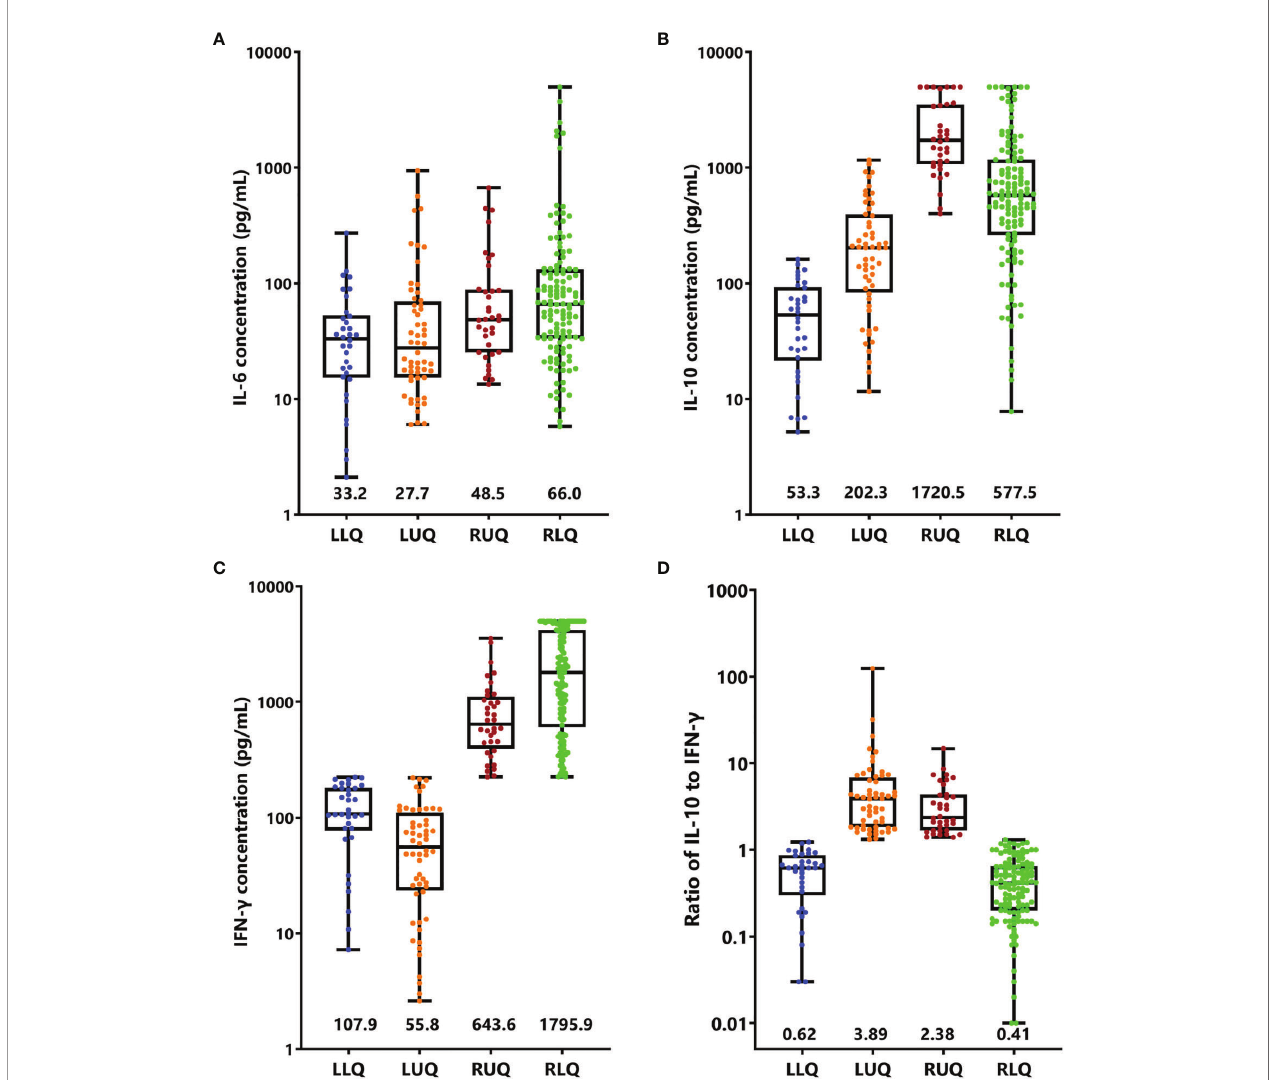
FIGURE 4 | Cytokine levels and ratios in four quadrants. Box-and-whisker plots of IL-6 (A) , IL-10 (B) , IFN- g (C) , and ratio of IL-10 to IFN- g (D) were shown. Median levels (lines), 25th to 75th percentiles (box), and minimum to maximum values (whiskers) are shown. The numbers in the plots are the median concentration of each cytokine or ratio. LLR, left lower quadrant; LUR, left upper quadrant; RUQ, right upper quadrant; RLQ, right lower quadrant.